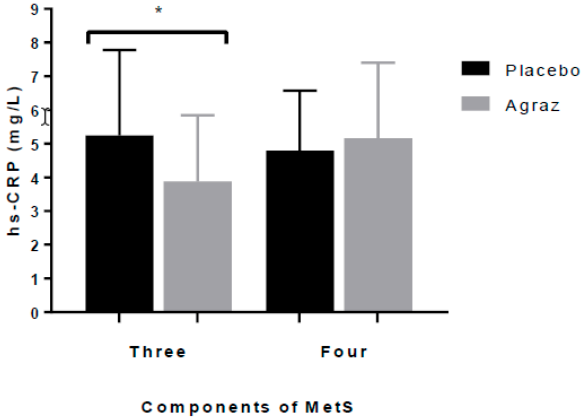
Figure 2. High sensitive C-reactive Protein (hs-CRP) levels in patients who presented three and four+ metabolic syndrome (MetS) parameters after placebo and agraz consumption. Values are presented as mean ± standard deviation. * Significance p ≤ 0.05. Table 4. Changes in markers of insulin resistance and inflammation in women with metabolic syndrome after agraz consumption compared to placebo.